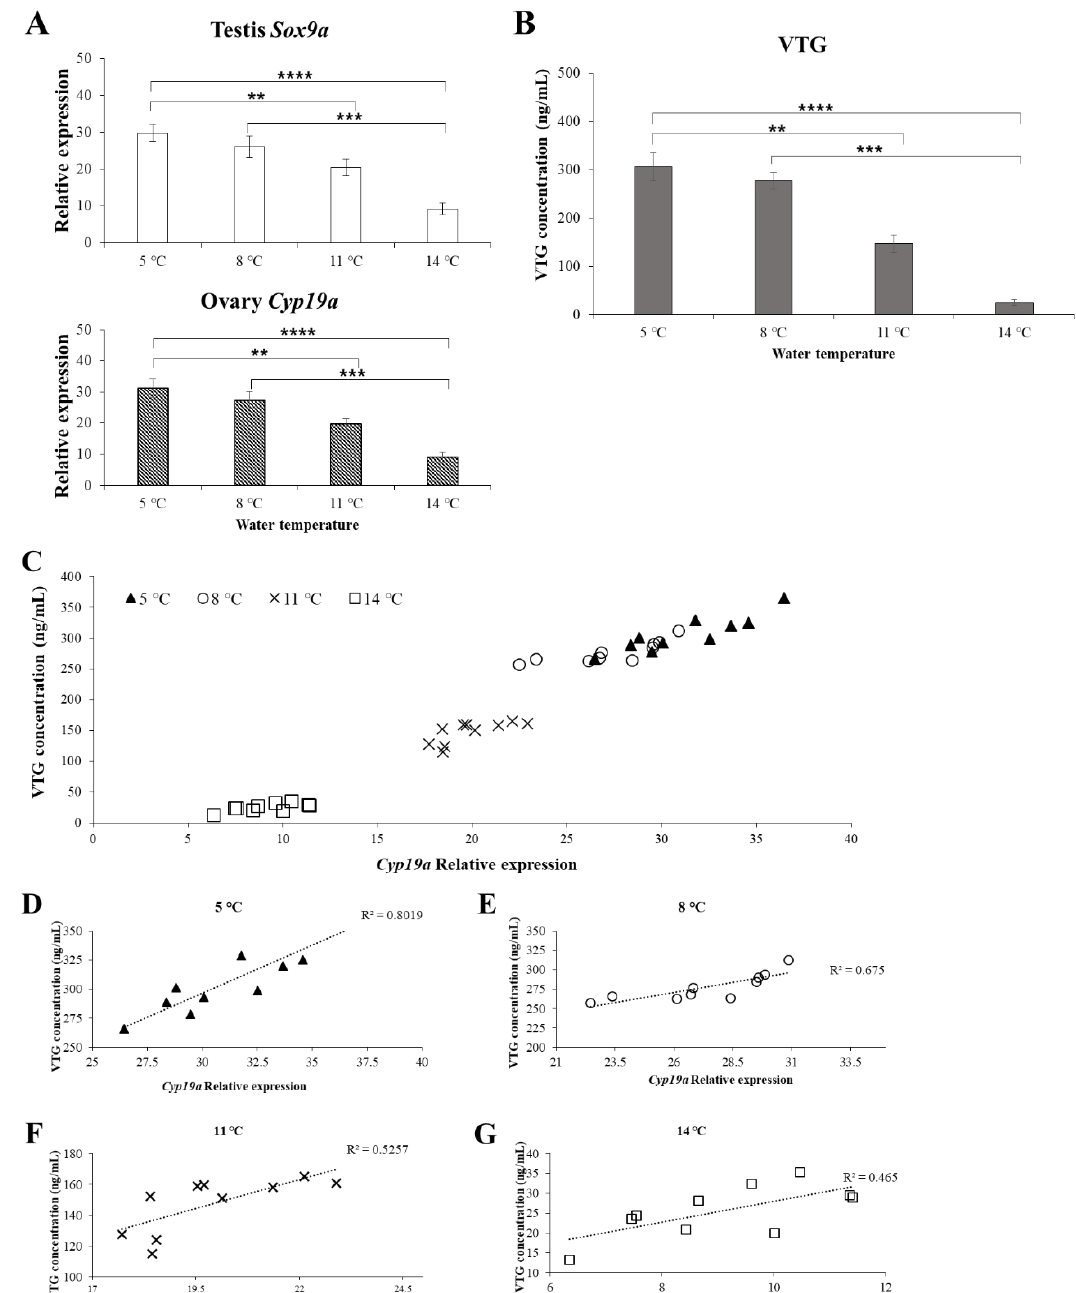
Figure 5. ( A ) Sox9a (white bars) and cyp19a (shaded bars) mRNA expression in immature walleye pollock gonadal tissues (testis and ovary) at different water temperatures; ( B ) VTG levels in female blood. ( C ) The correlation between cyp19a and VTG at different water temperatures. ( D ) The correlation between cyp19a and VTG at 5 ° C ( ▲ ), ( E ) The correlation between cyp19a and VTG at 8 ° C ( ○ ), (f) The correlation between cyp19a and VTG at 11 ° C (X), and ( G ) The correlation between cyp19a and VTG at 14 ° C (□). The expression of each sample was relative quantity to the expression of 18s rRNA. Kruskal–Wallis with post-hoc Dunn’s multiple comparison tests were used. Values are reported as mean ± SD of the three experiments. * indicates P < 0.05, ** indicates P < 0.01, *** indicates P < 0.001, **** indicates P < 0.0001.